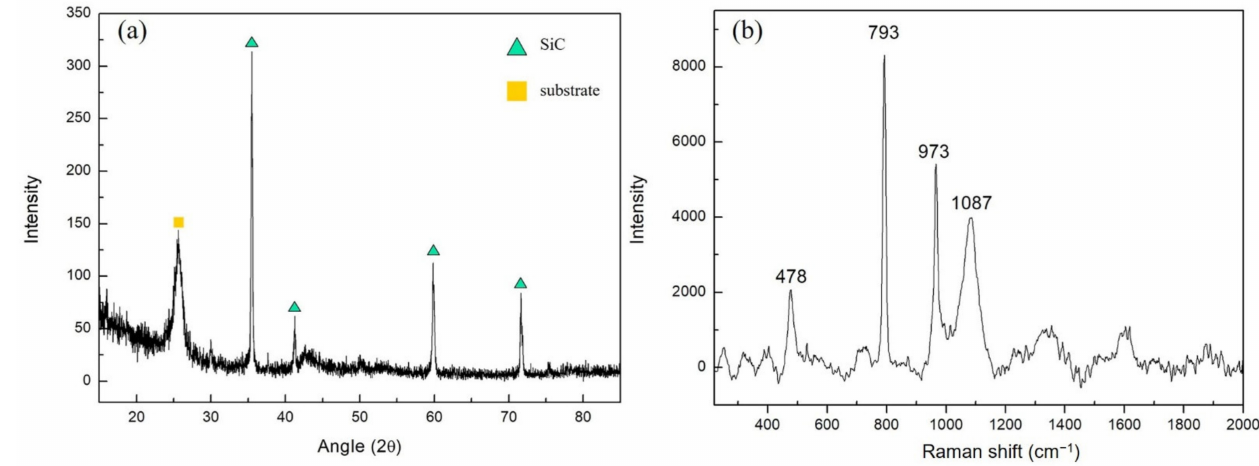
Figure 2. ( a ) XRD pattern for the multi-layer SiC. ( b ) Raman spectra for the multi-layer SiC.